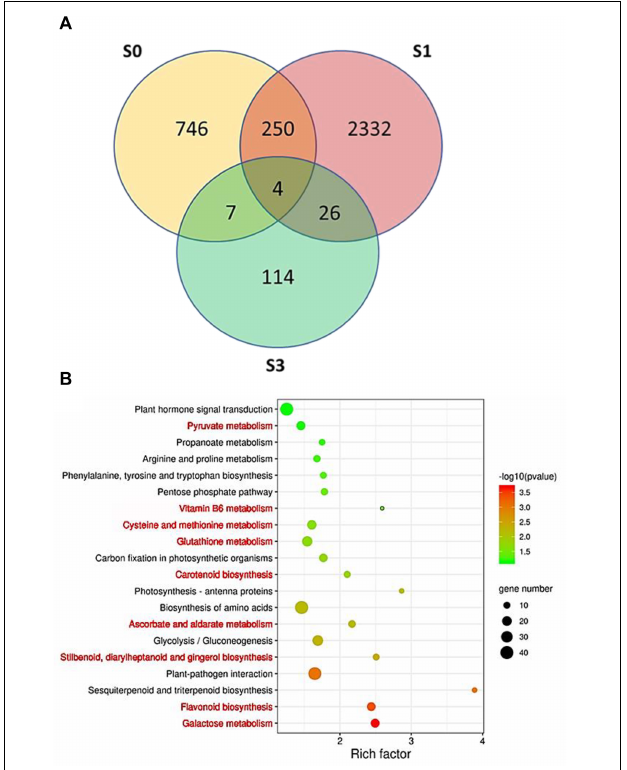
FIGURE 7 | Identification of differentially expressed genes (DEGs) between the anthers of “JX” and “ZH.” (A) Venn diagram of DEGs at S0, S1, and S3. (B) Top 20 most represented categories of KEGG and the gene number predicted to belong to each category. The pathways involved in ROS homeostasis system are highlighted in red